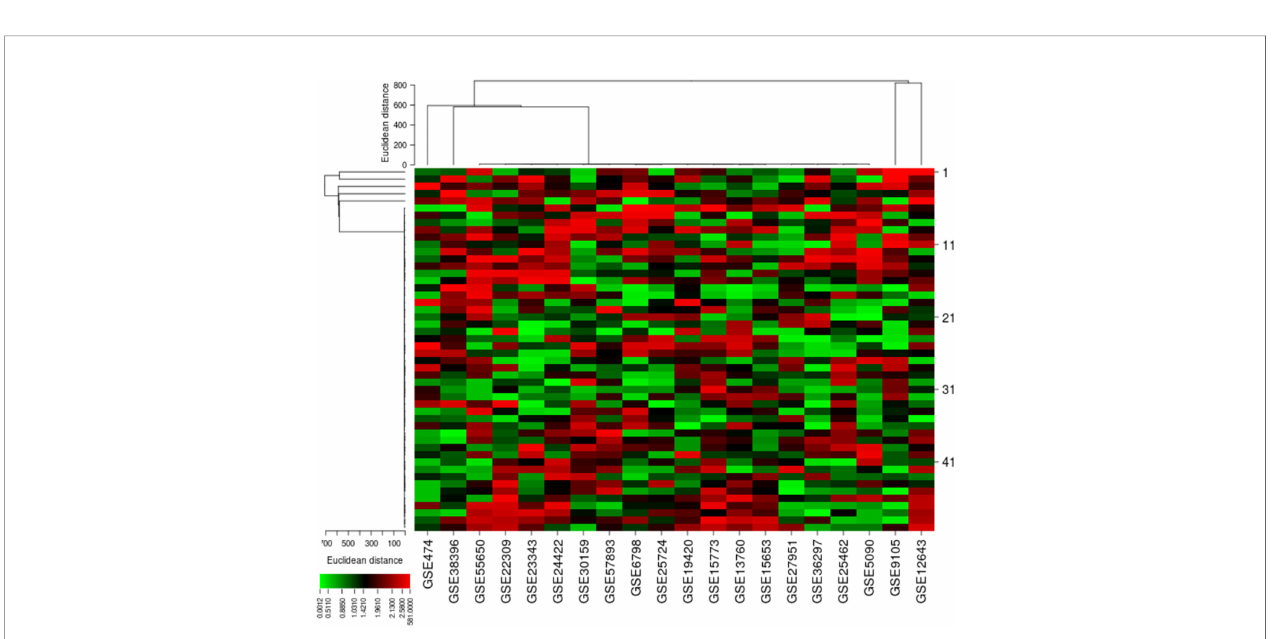
FIGURE 2 | Differential expressions of 50 genes obtained from microarray cDNA datasets. The heat map indicates the differential expressions of these genes in each type 2 diabetes mellitus (T2DM)-related dataset.